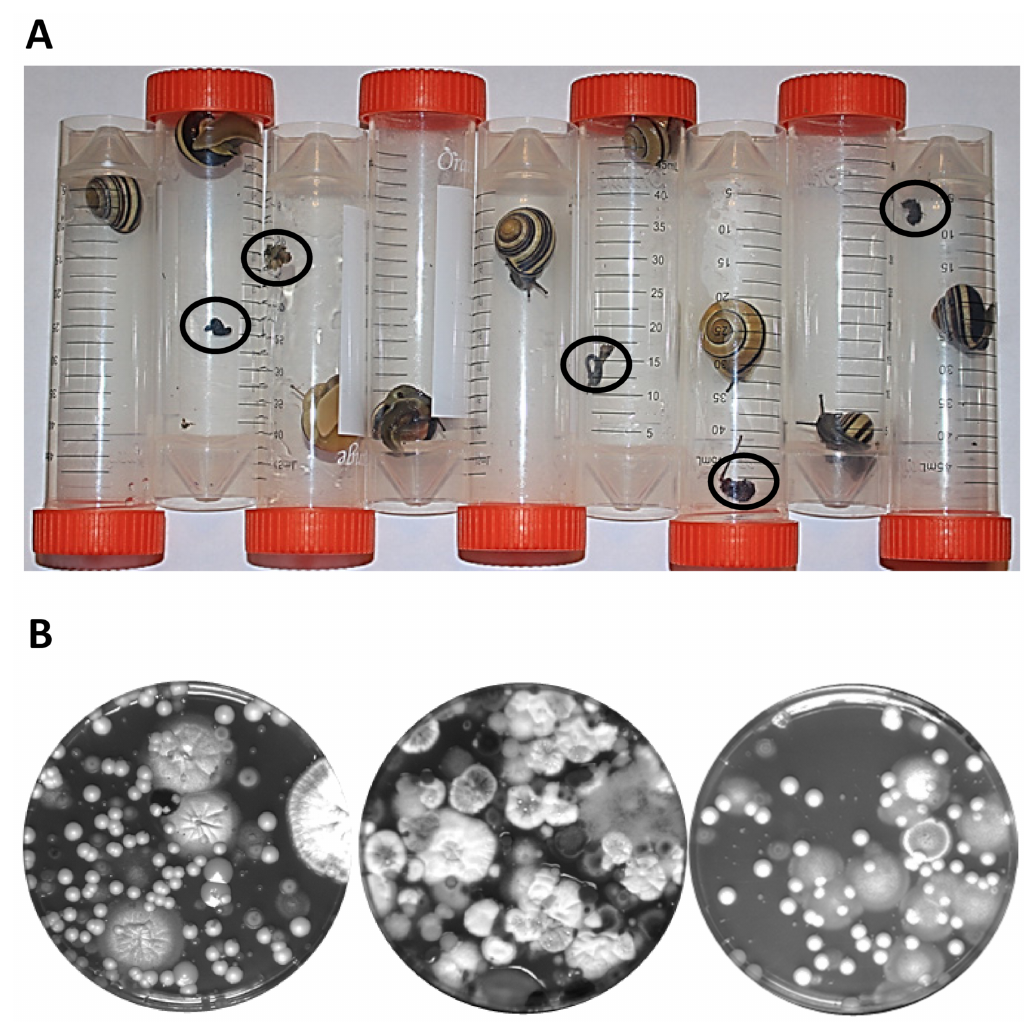
Figure 2. Isolation of yeasts from Cepaea snails. ( A ) Snails were isolated in Falcon tubes until they delivered excrements (encircled). Their confinement lasted for several hours up to overnight. ( B ) Dilution plating of solubilized snail excrements on YPD petri plates. Di ff erent sample